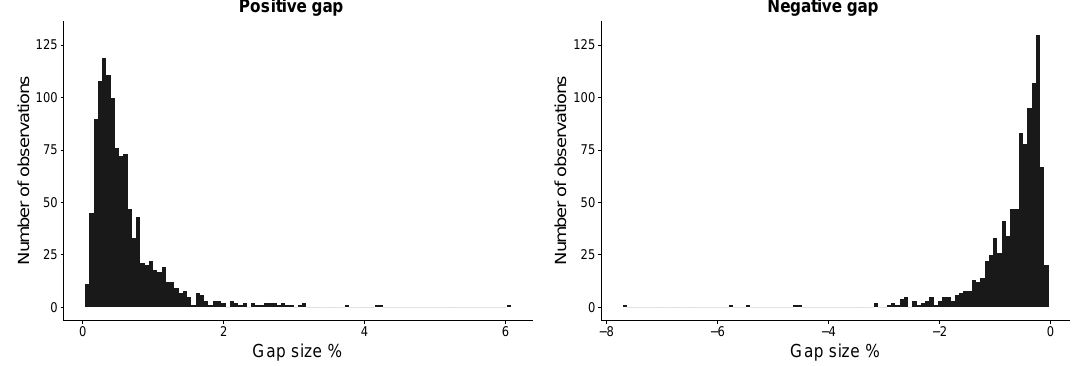
Figure 1. Histogram of positive and negative overnight gaps, which were identified by the BNS jump test, from January 1998–December 2015.